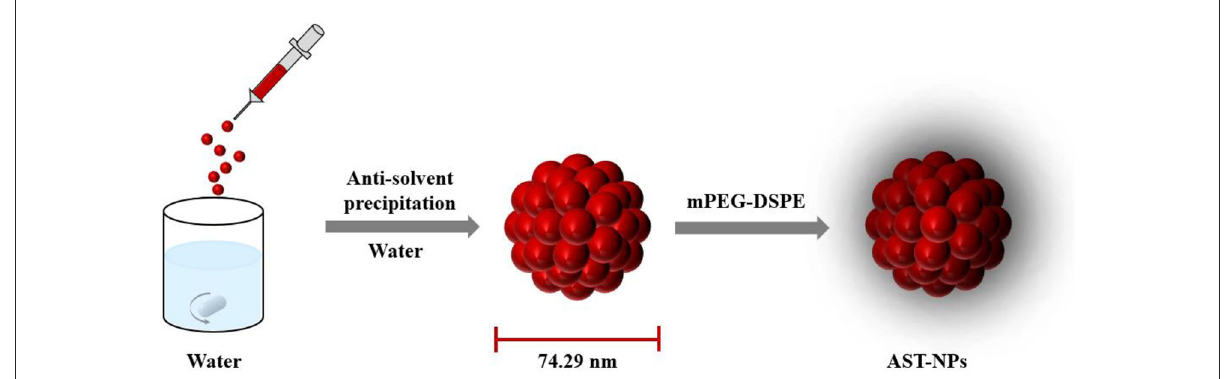
FIGURE1 Schematic illustration of the